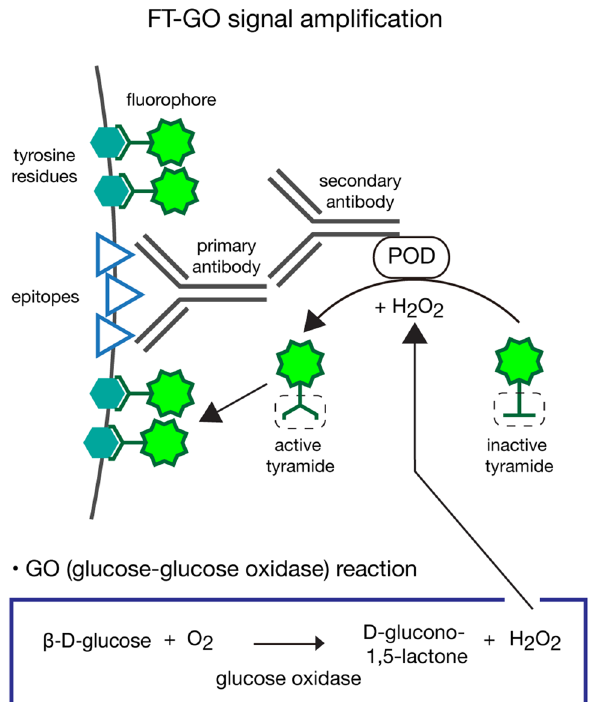
Figure 1. FT-GO signal amplification. Schematic diagram of FT-GO signal amplification in IF. FT-GO is a fluorescent TSA system that utilizes H 2 O 2 produced during oxidation of glucose by glucose oxidase to deposit FT. POD reacts with the H 2 O 2 , and oxidizes the phenolic part of tyramide to produce highly reactive intermediates, tyramide radicals, which in turn covalently bind to electron-rich moieties such as tyrosine residues at or near the